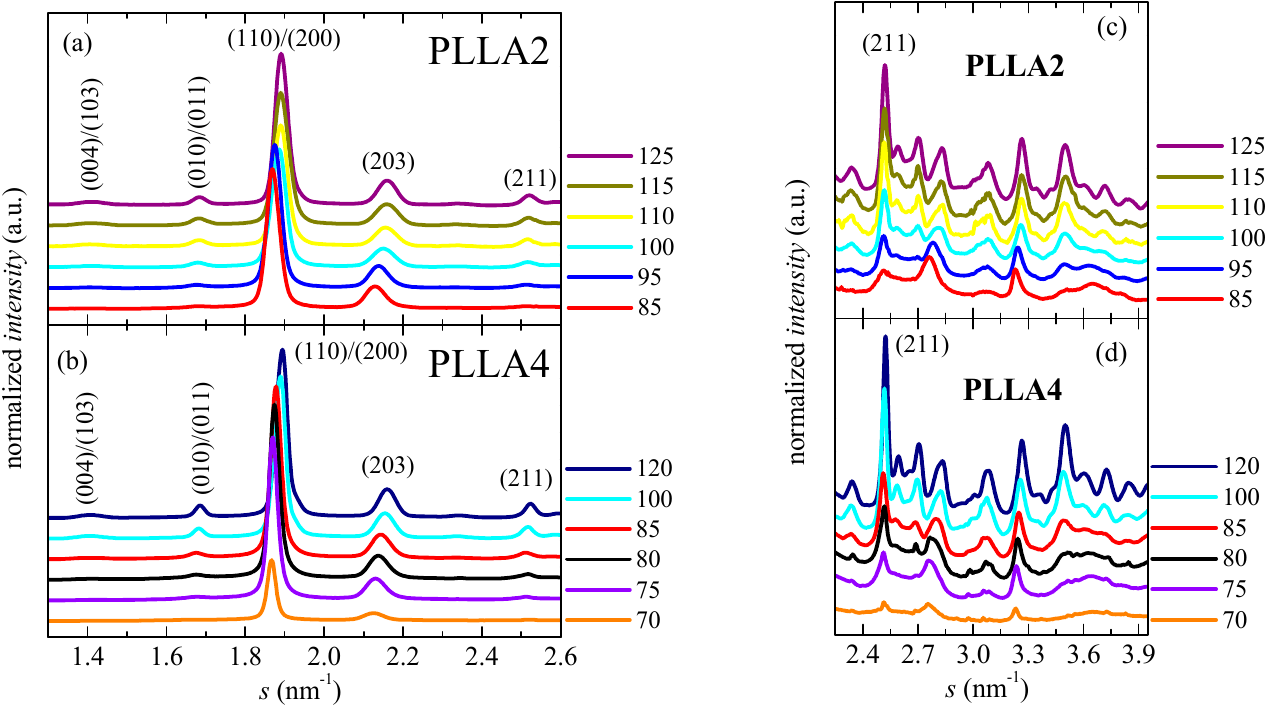
Figure 8. Synchrotron pure crystal WAXS profiles, at room temperature. Scattering intervals: ( a , b ) from 1.30 to 2.60 nm − 1 ; and ( c , d ) from 2.25 to 3.95 nm − 1 , for PLLA2 and PLLA4 after isothermal cold crystallization at different temperatures. The main Miller indices are indicated.